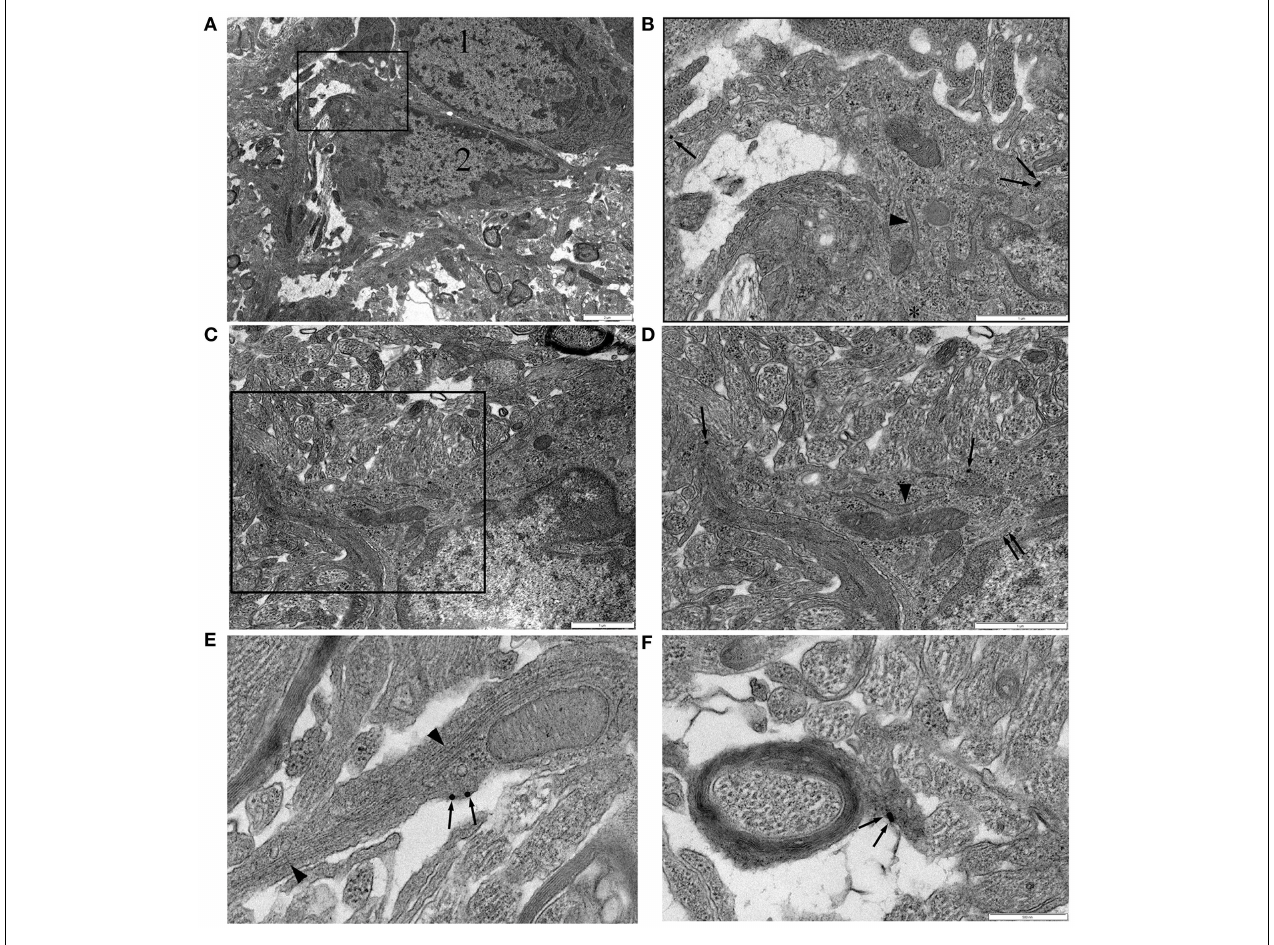
FIGURE 4 | NG-2 immuno-gold labeling in P10 RON. (A,B) Two closely apposed glial soma (“1” and “2”). Cell “1” has features typical of an early cell of the oligodendroglial lineage including an ovoid nucleus and narrow bore ER. Cell “2” has features that are typical of astrocytes in this preparation. The boxed area is shown at higher gain in ( B ). Note the gold particles (some indicated by arrows) which identify this cell as NG-2( + ). A lobular nuclear morphology with clustered chromatin under the nuclear envelope and a wide